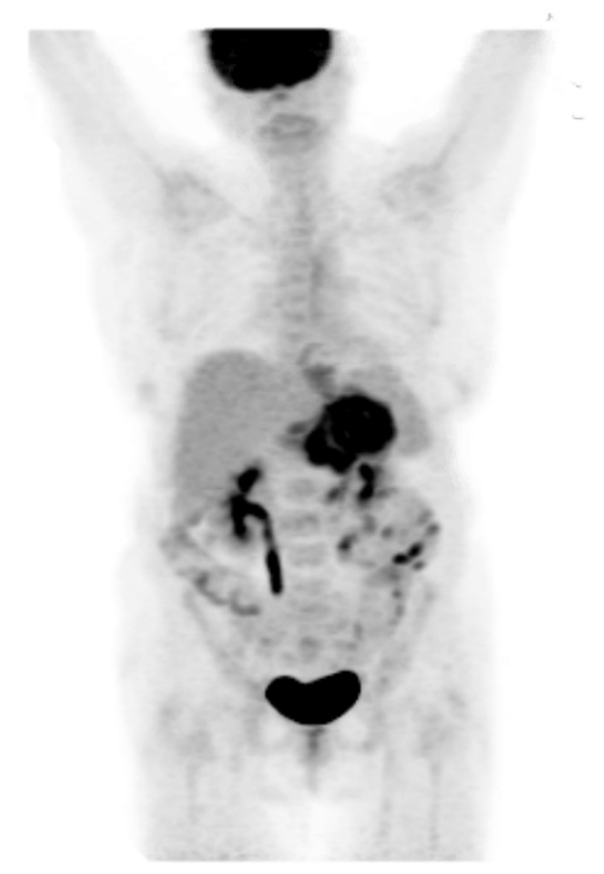
Figure 4. Pre-chemotherapy staging PET scan shows a locally advanced gastric cancer. PET from skull to mid-thigh reveals extensive, diffuse hypermetabolism throughout the gastric wall compatible with a PET-avid infiltrating gastric neoplasm. Imaging revealed involvement of at least one hepatogastric lymph node. Thus, the patient was determined to have stage III disease (T3N1). Scattered areas of contrast uptake within the bowel are likely physiologic and limit evaluation for lesions. Contrast uptake within the brain and genitourinary system are